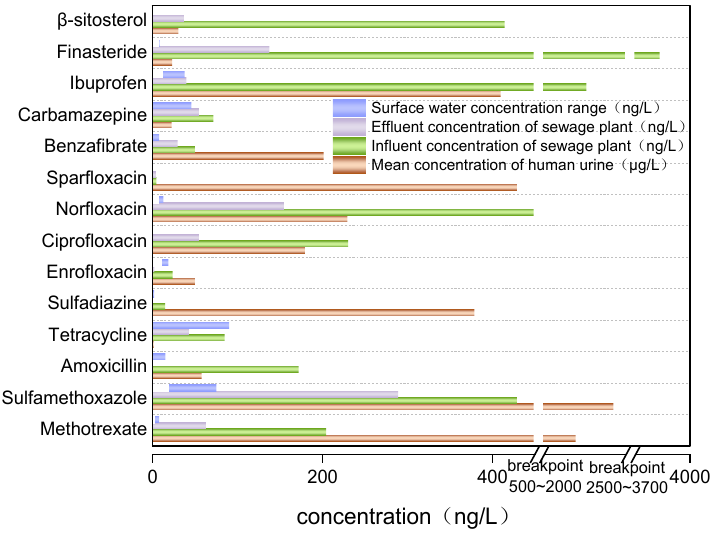
Figure 3. Concentration distribution of pharmaceutical contaminants in human urine, sewage plants, and surface water (data from [43,47–69]).